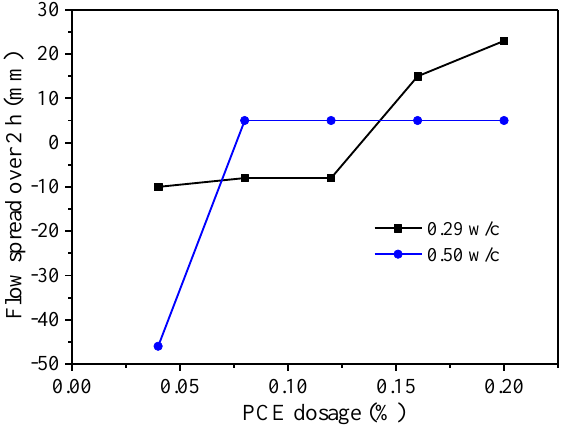
Figure 11. Time change of flow spread over 2 h.